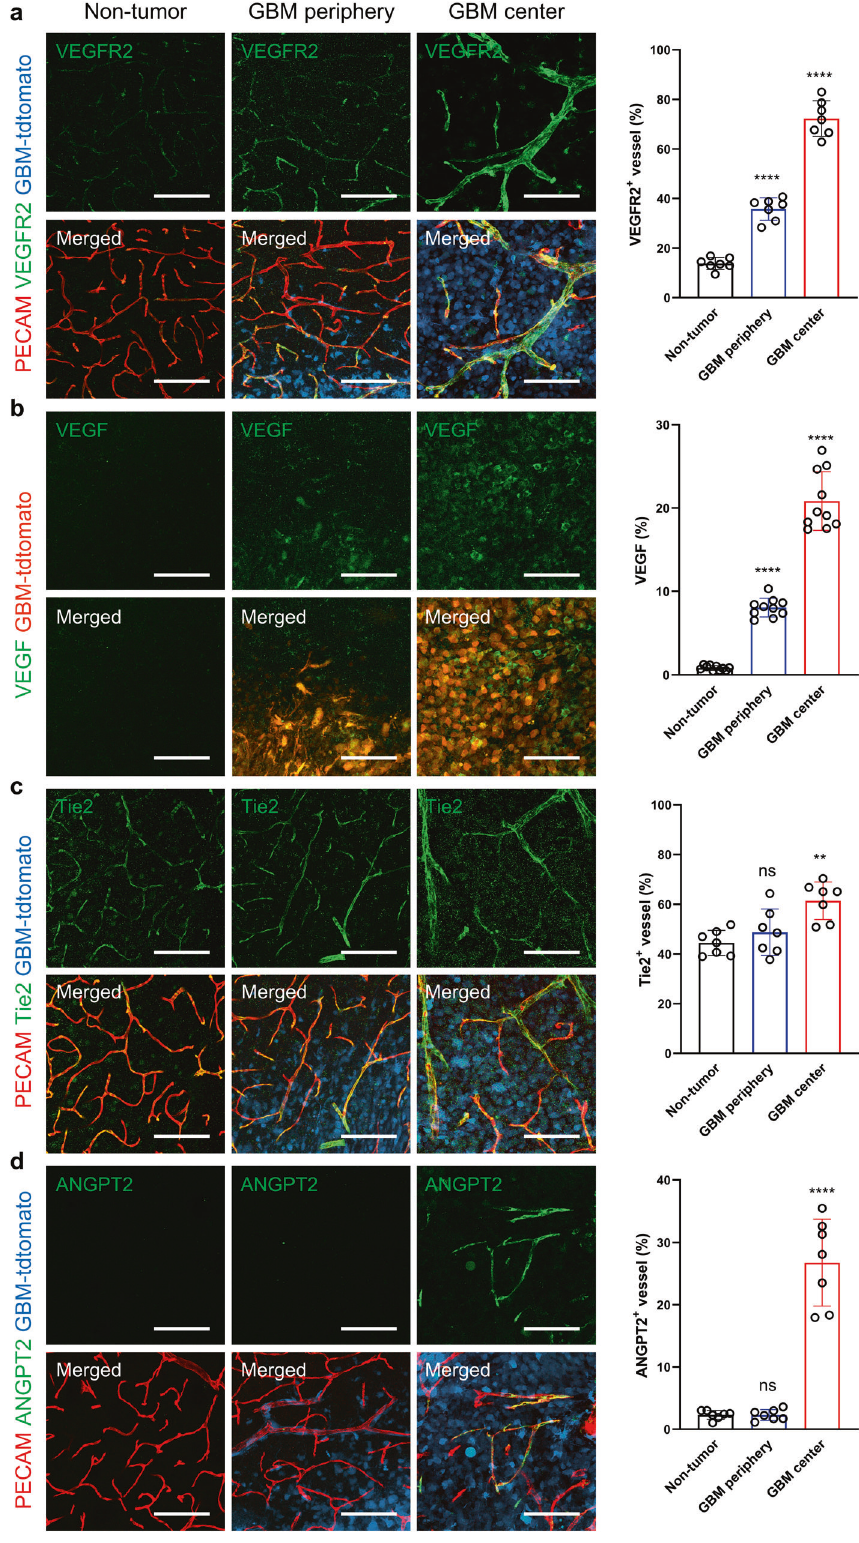
Fig. 2 Levels of VEGF and VEGFR2 correlate spatially with the normal-to-tumor vascular transition. a – d Immunostaining images of nontumor brain tissue and the periphery and center of EGFR VIII GBM tumors and quanti fi cation of staining: ( a ) VEGFR2, ( b ) VEGF, ( c ) Tie2, and ( d ) ANGPT2. Scale bars: 100 µm ( a – d ). ns not signi fi cant; **, P < 0.01; ****, P < 0.0001 vs. nontumor